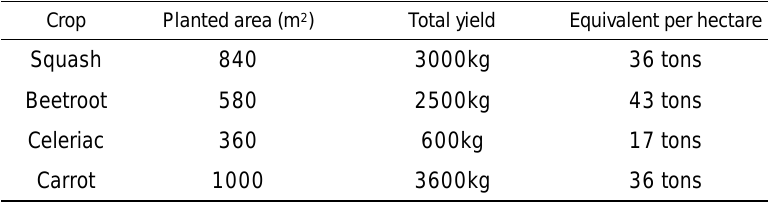
Table 3. Estimated Yields Produced per Crop at Canalside